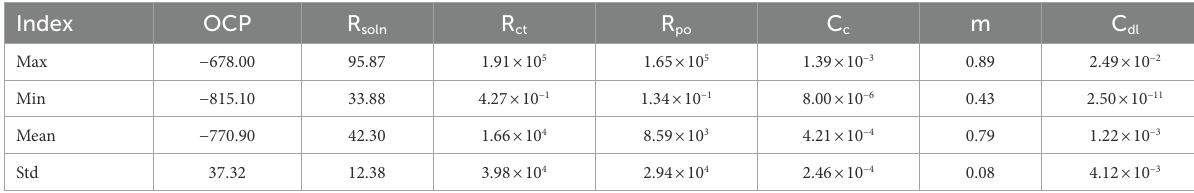
TABLE 1 Characteristics of the real corrosion data used in machine learning model.